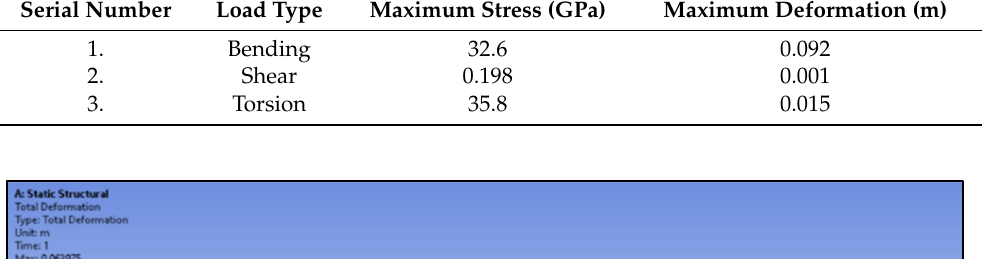
Table 17. Wing subjected to 100 kN.